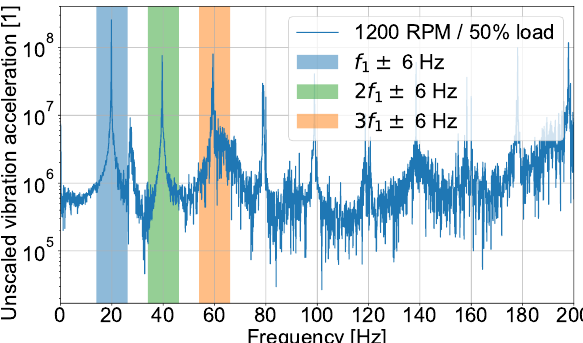
Figure 10. FFT of the measured vibration signal, showing the ± 6 Hz frequency range around the three first harmonic frequencies from which the statistical features are